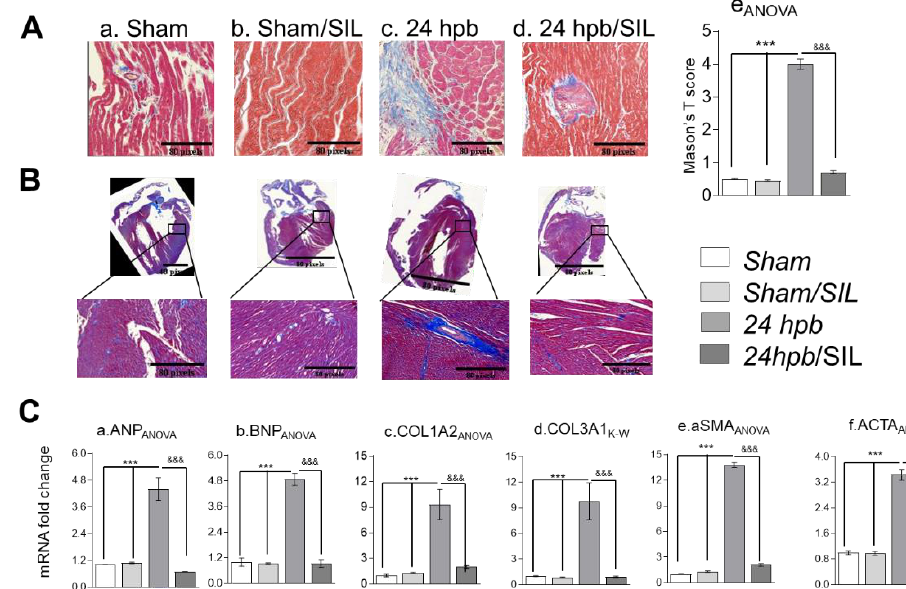
Figure 3. Effect of PDE5 inhibition on burn-induced cardiac fibrogenesis . Sprague–Dawley rats were randomized to a 60% TBSA scald burn or sham procedure with standard resuscitation with/without sildenafil (SIL). Heart tissues and blood were harvested at 24 h post burn (24 hpb ± SIL). ( A ) Representative myocardial fibrosis levels via Masson’s trichrome staining (panels a–d). ( B ) Representative whole hearts stained with Masson’s trichrome and scored for fibrosis (panel e). ( C ) Quantitative RT-PCR analysis of mRNA levels for fibrosis markers. Shown are atrial natriuretic peptide (panel a, ANP), natriuretic peptide B (panel b, BNP), collagen isoforms COLIA2 and COL IIIA1 (panels c & d), actin, alpha, cardiac muscle 1 (aSMA, panel e), and actin, alpha 2, smooth muscle, aorta (panel f). Results were normalized to rat GAPDH and β -actin mRNAs, and represent fold change after the burn ( ± SIL), as compared to that noted in matched normal controls. In all figures, data are plotted as mean value ± SEM (n ≥ 6 per group). Significance is shown as * (24 hpb vs. matched control) or & (24 hpb / untreated vs. 24 hpb / SIL), and presented as *** ,&&& p < 0.001 (n = ≥ 6 per group).